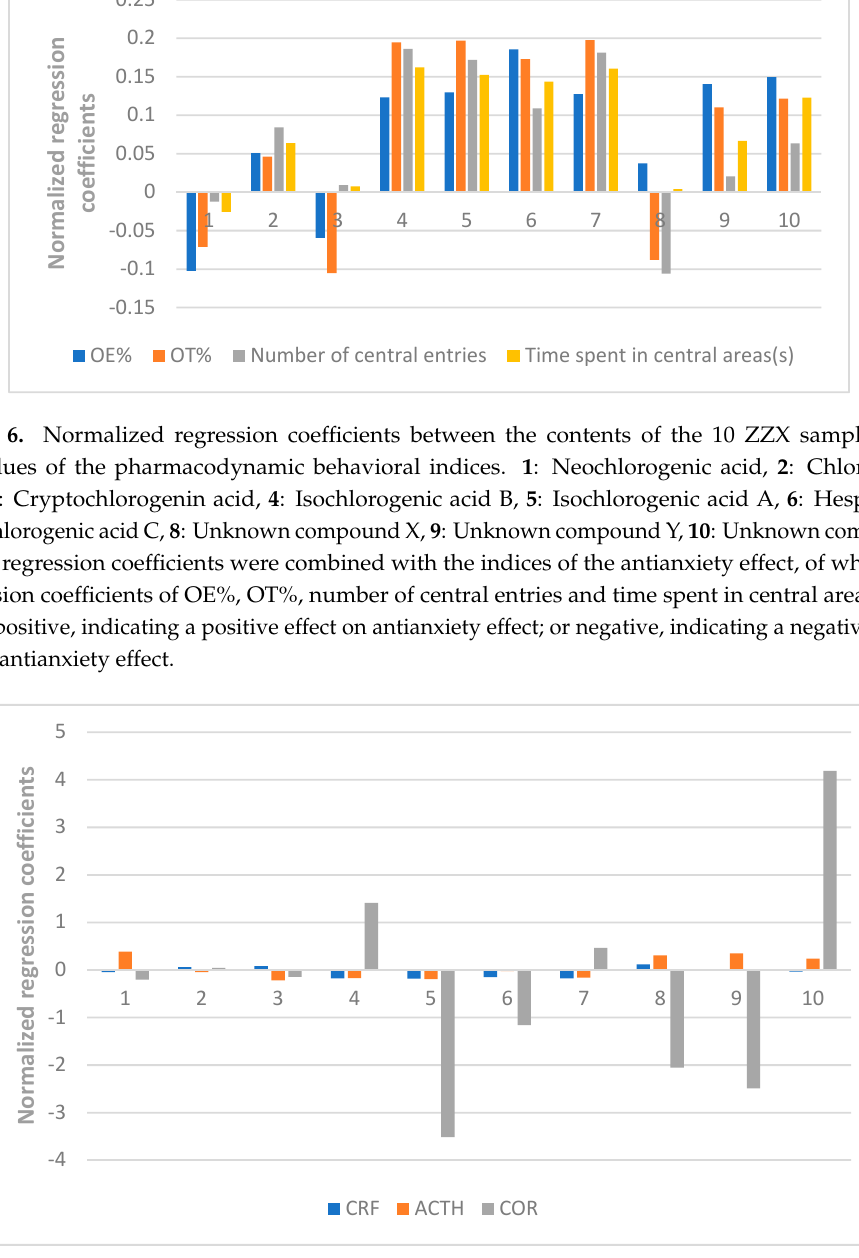
Figure 7. Normalized regression coefficients between the contents of the 10 ZZX samples and the concentration of CRF, ACTH, CORT in serum. 1 : Neochlorogenic acid, 2 : Chlorogenic acid, 3 : Cryptochlorogenin acid, 4 : Isochlorogenic acid B, 5 : Isochlorogenic acid A, 6 : Hesperidin, 7 : Isochlorogenic acid C, 8 : Unknown compound X, 9 : Unknown compound Y, 10 : Unknown compound Z. The regression coefficients were combined with the indices of the anti-anxiety effect, of which the regression coefficients of CRF, ACTH, COR were either positive, indicating a negative effect on anti-anxiety effect; or negative, indicating a positive effect on the anti-anxiety effect.